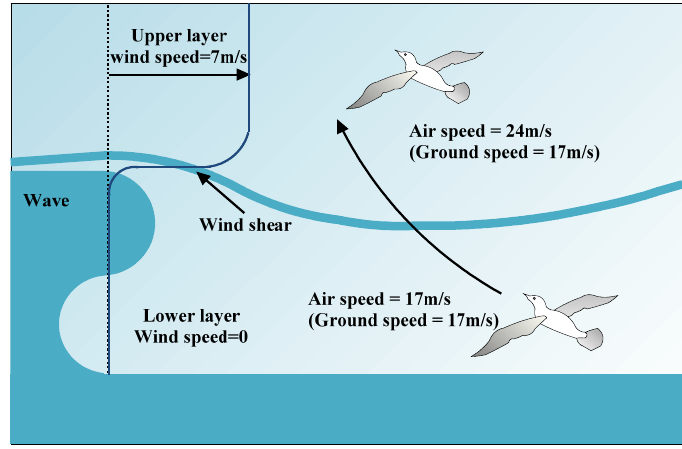
Figure 1. An albatross flying over the sea to obtain extra airspeed. Because the wind speed below the wave is nearly zero and the wind above the wave has a certain speed, the wind can be considered to comprise two layers with a wind shear between them. Suppose that the initial airspeed of the albatross is 17 m/s in the wind layer below the wave. If the wind speed above the wave is 7 m/s higher than that below the wave, when the albatross faces the wind and crosses the wind shear between the lower and upper wind layers, the airspeed would suddenly increase to 24 m/s. This sudden gain in speed is due to the lack of time for the albatross to change its ground speed.